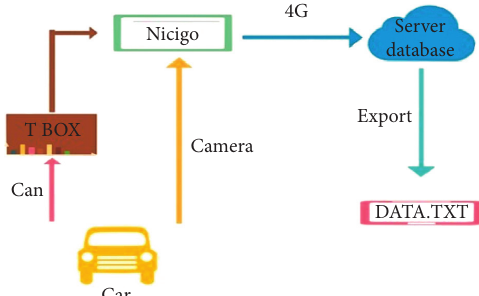
Figure 1: Operating principle of the experimental data acquisition system.